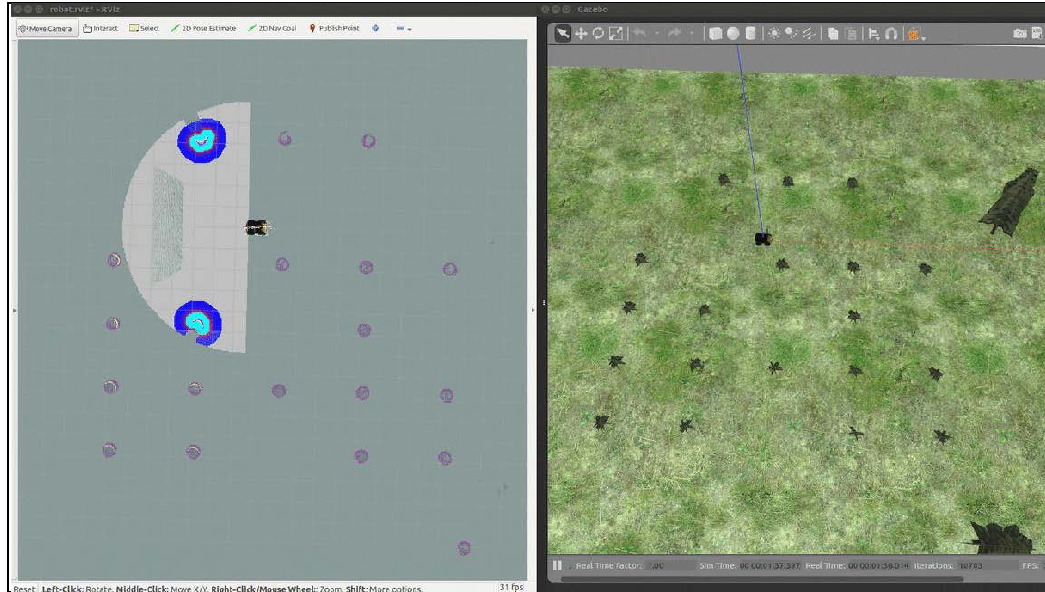
Figure 10. Dynamic area coverage by the UGV in AgROS.